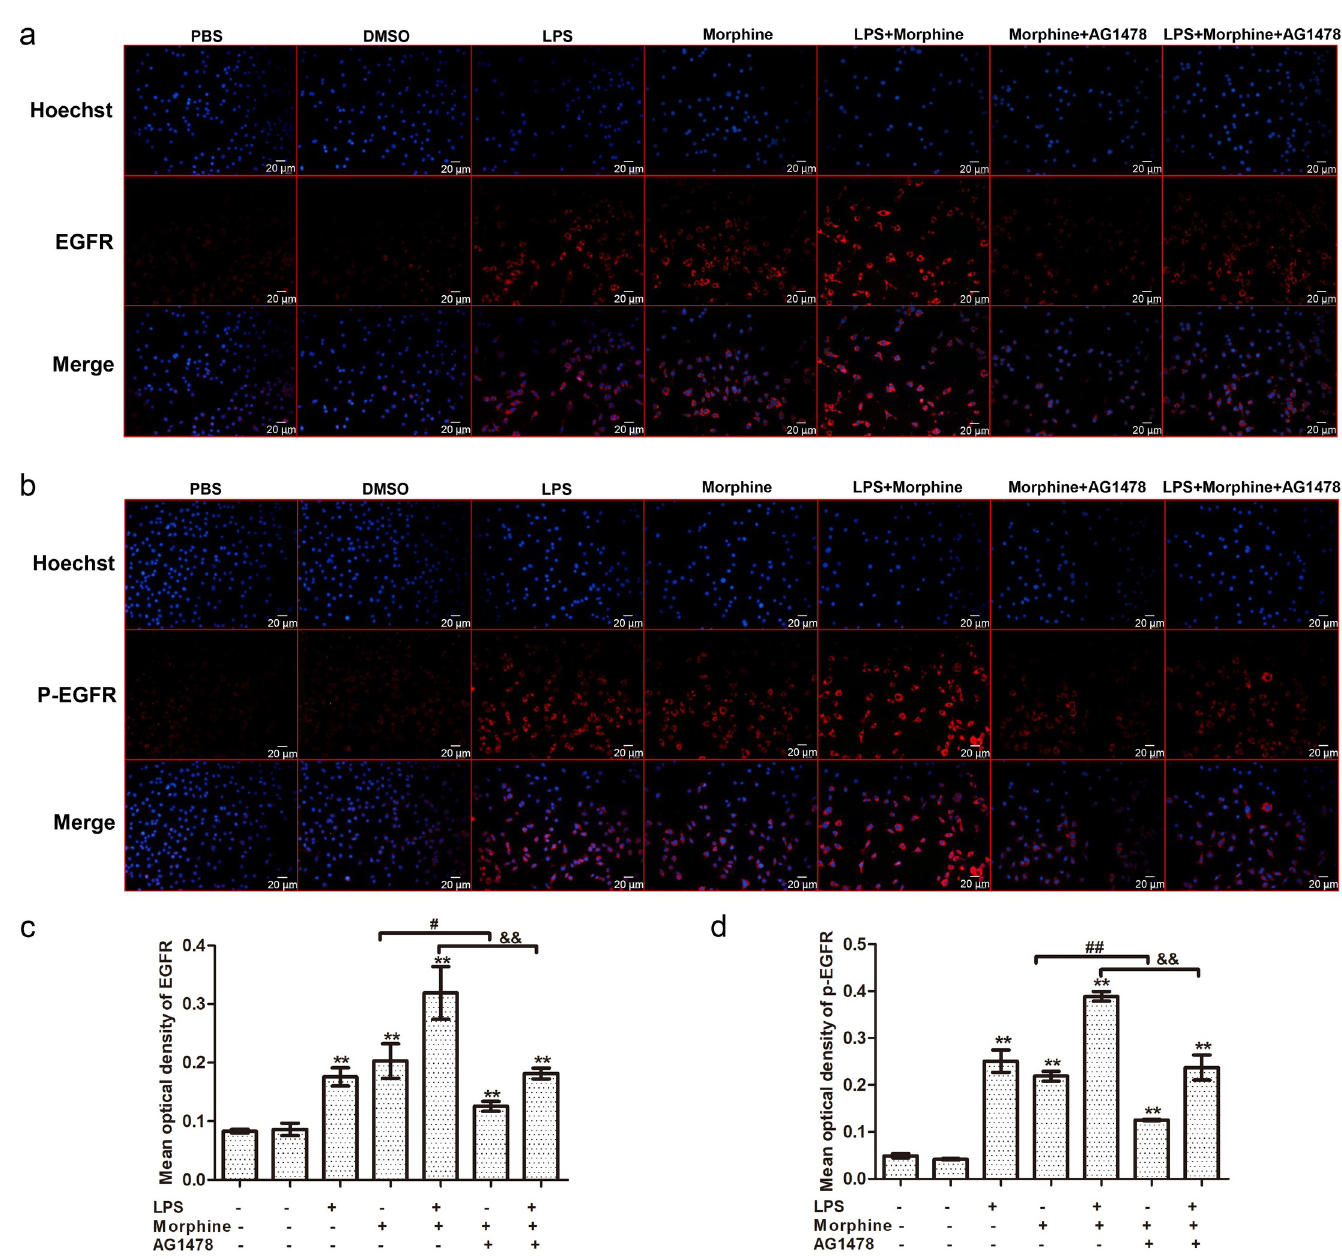
Fig 4. The effect of morphine and LPS on expression of EGFR and p-EGFR. The expression of EGFR (a) and p-EGFR (b) in BV-2 cells was detected by immunocytochemical analysis. Scale bar: 20 μ m. (c), (d) The mean optical densities of six randomly selected fields of cells from each group were analyzed by ImageJ software for quantitative analysis. Data are expressed as the means ± SEMs. All data were analyzed using ANOVA. � p < 0.05 and �� p < 0.01 compared to the control groups. # p < 0.05 and ## p < 0.01 morphine vs. morphine + AG1478. & p < 0.05 and && p < 0.01 LPS + morphine vs. LPS + morphine + AG1478. https://doi.org/10.1371/journal.pone.0256870.g004 prior to treatment with morphine. Western blotting results revealed that protein expression of CD11b was significantly increased when cells were treated with morphine and markedly inhib- ited by AG1478 (Fig 5A). Morphine increased phosphorylation levels of EGFR but had no sig- nificant effect on total levels of EGFR. Treatment with AG1478 reversed the increase in EGFR levels induced by morphine (Fig 5B). We also found that expression of p-ERK1/2 was clearly